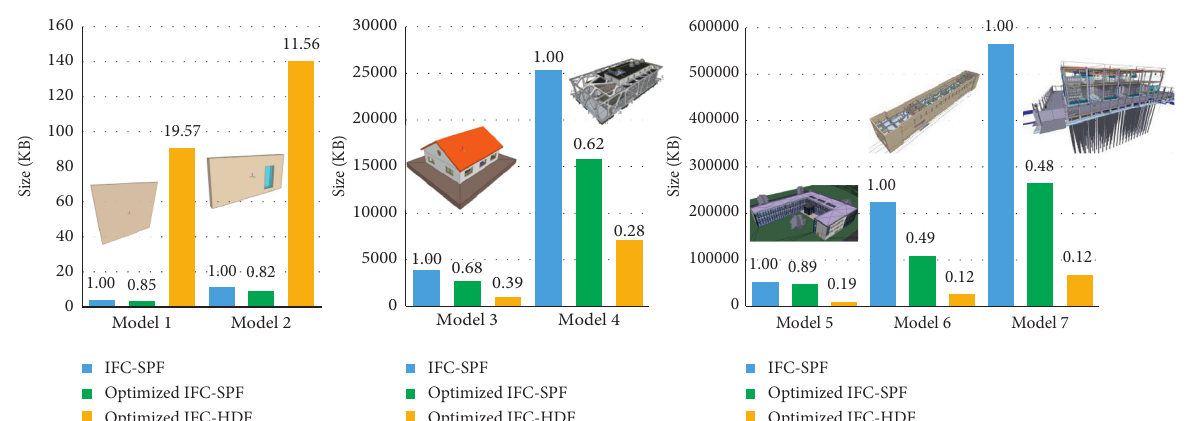
Figure 21: Comparison of the file size of IFC-SPF, optimized IFC-SPF, and IFC-HDF (optimized IFC-SPF means the intermediate IFC-SPF after data